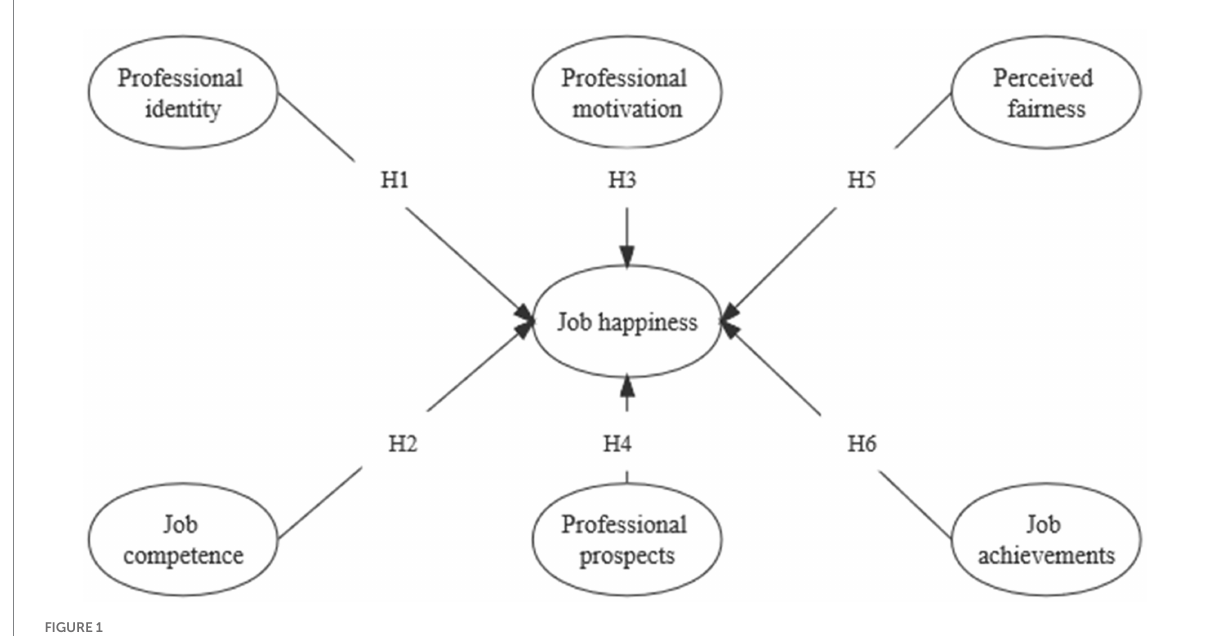
FIGURE 1 Theoretical